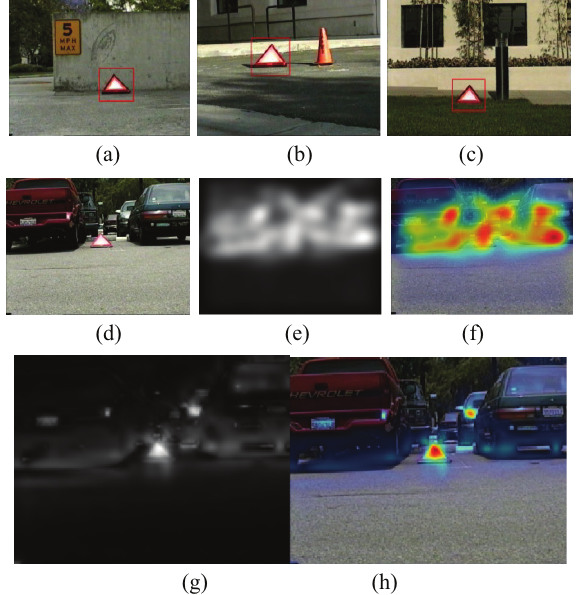
Fig. 4. Results of Experiment 1 where our target is a triangle (all images are from iLab Image Databases 25 ): (a) Training image 1 (b) Training image 2 (c) Training image 3 (d) Test input image (e) Itti’s saliency map (f) Itti’s saliency map represented as a heat map (g) our saliency map (h) our saliency map represented as a heat map